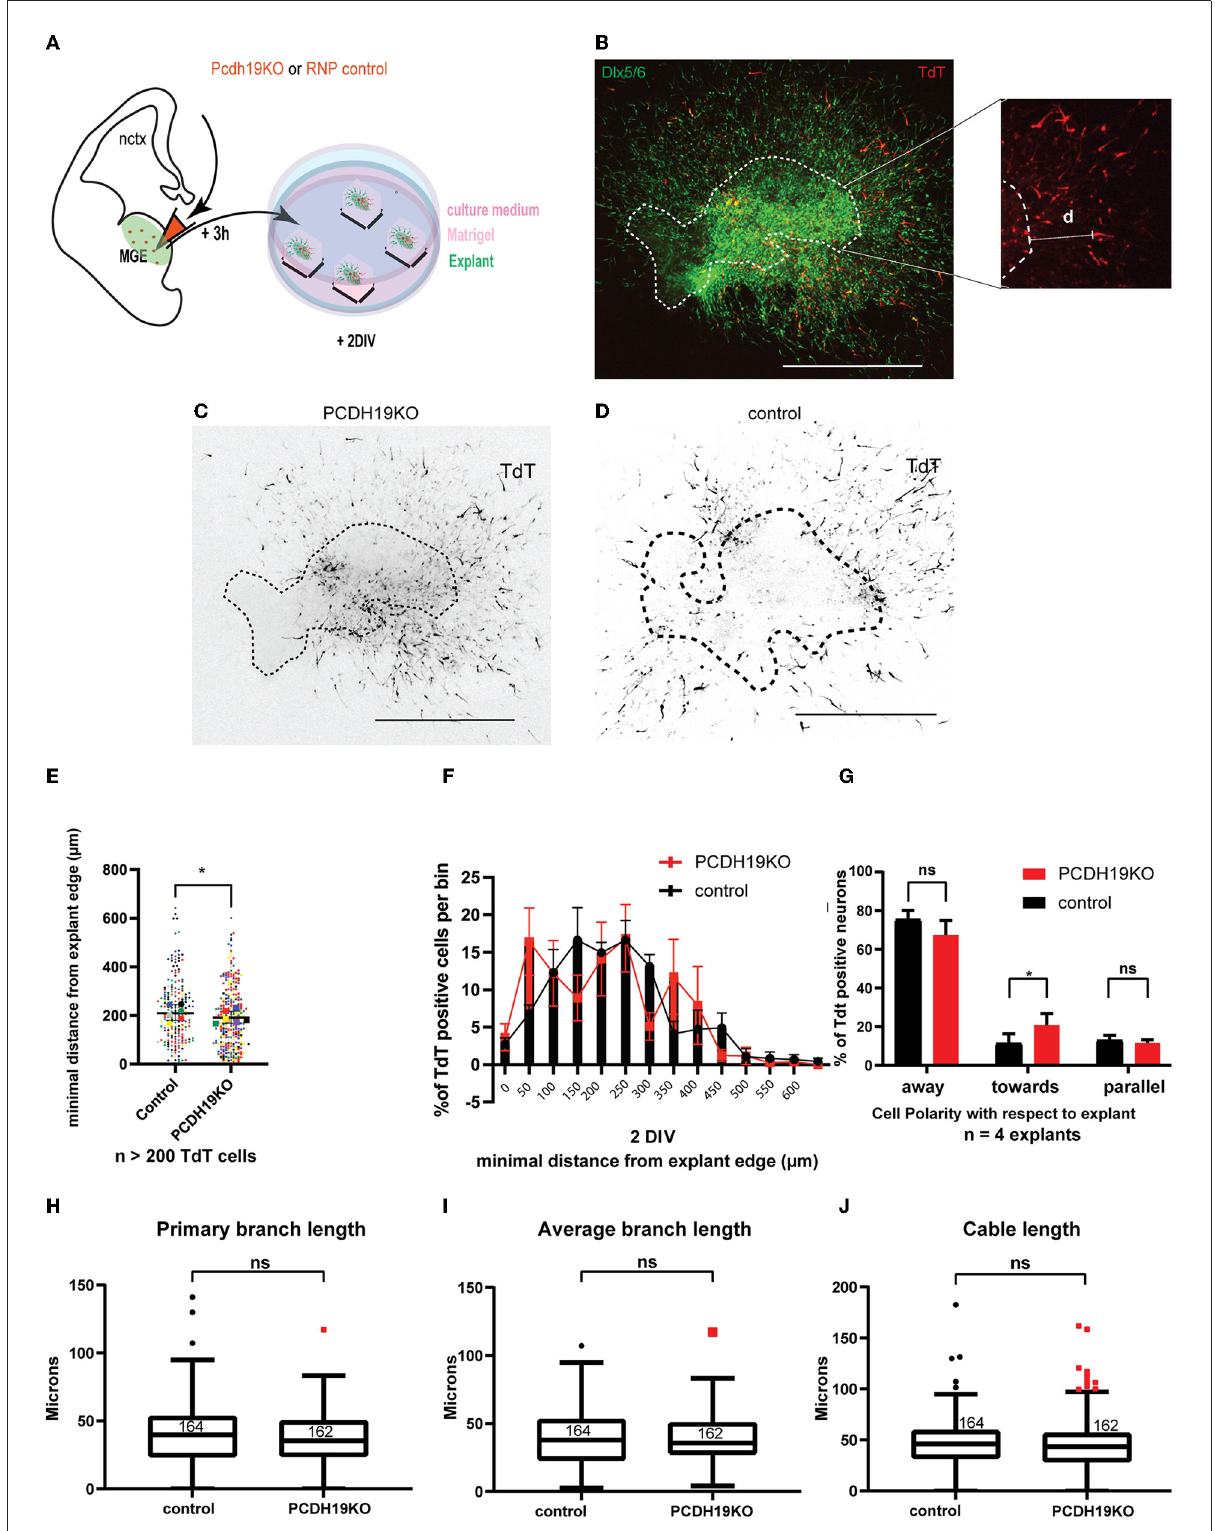
FIGURE6 Subtle effect of PCDH19 loss on the total minimum migration distance of MGE explants-derived INs might arise from disturbed migration polarity. (A) A schematic of the ex vivo MGE explant electroporation setup to investigate the effect of PCDH19 KO in MGE-derived IN. (B)